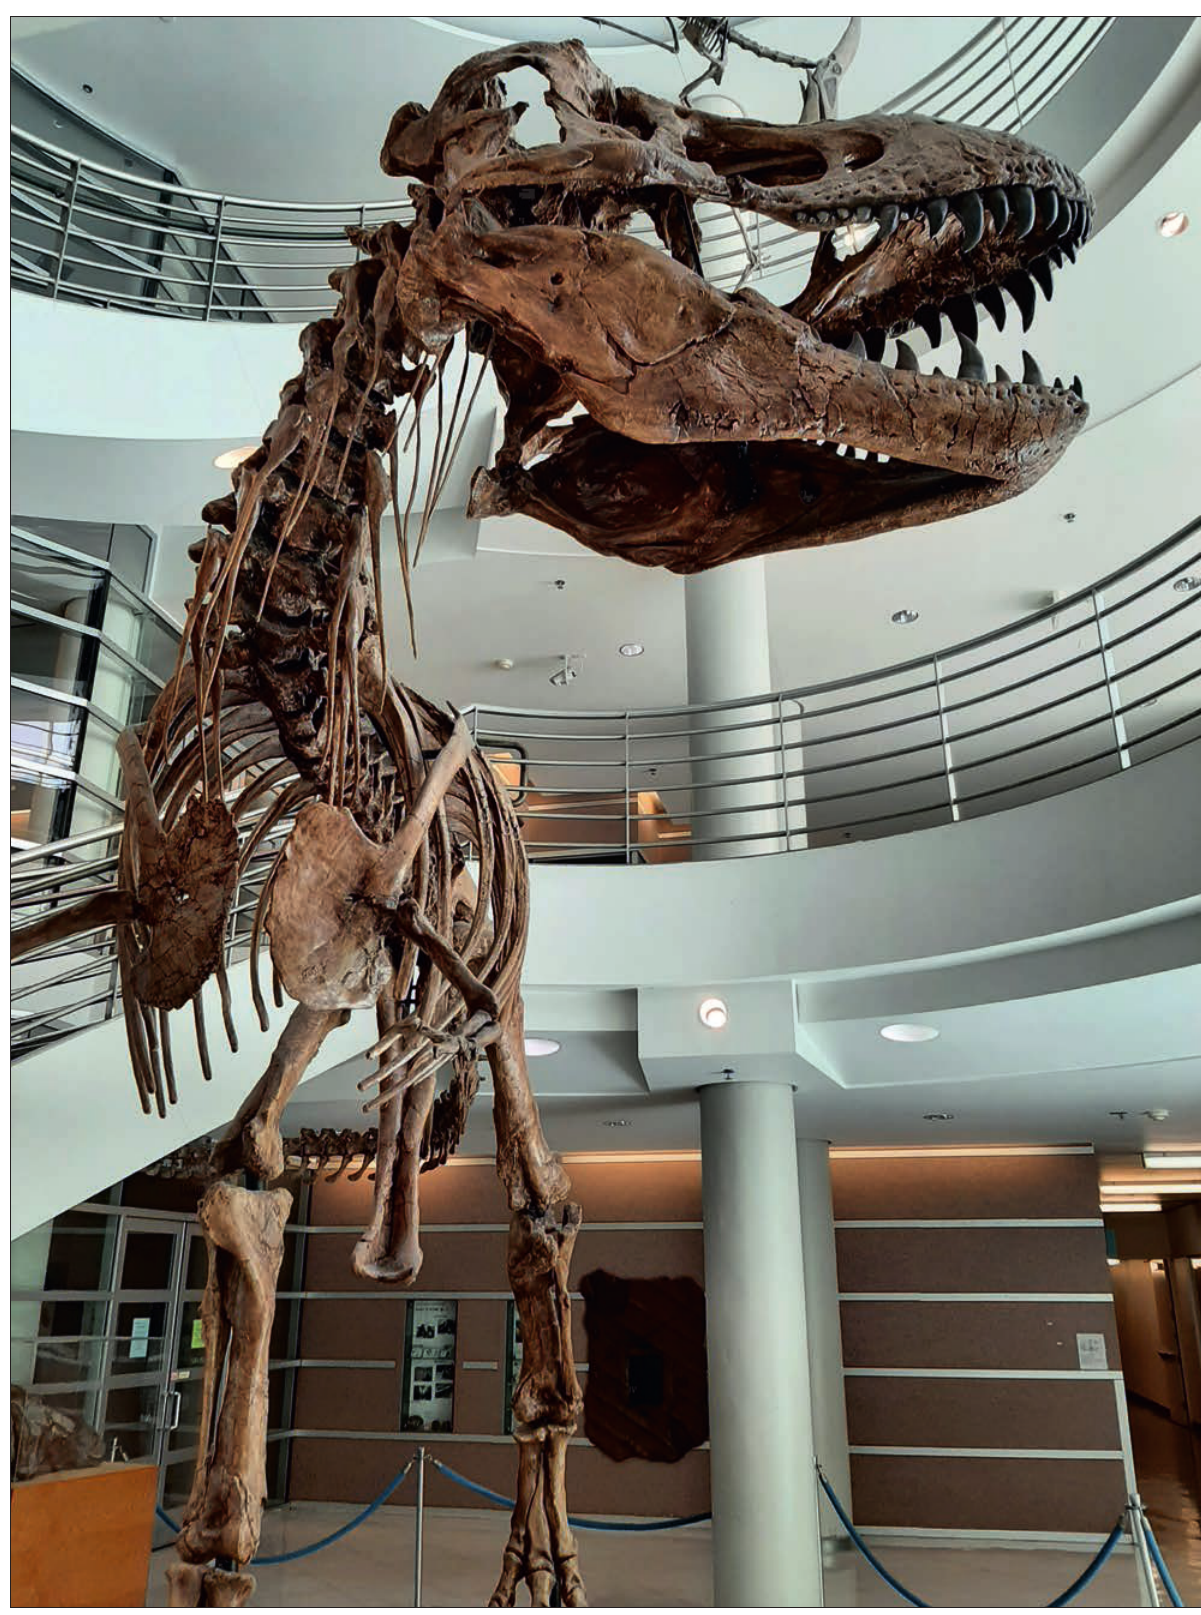
Fig. 1. The mounted skeleton of Tyrannosaurus rex Osborn, 1905, in the atrium of the Valley Life Sciences Building at the University of California, Berkeley based mainly on the relatively complete skeleton in the Museum of the Rockies (MOR 555), collected from the latest Cretaceous Hell Creek Formation of Montana, USA. Courtesy University of California Museum of Paleontology and the Regents of the University of California. For details see